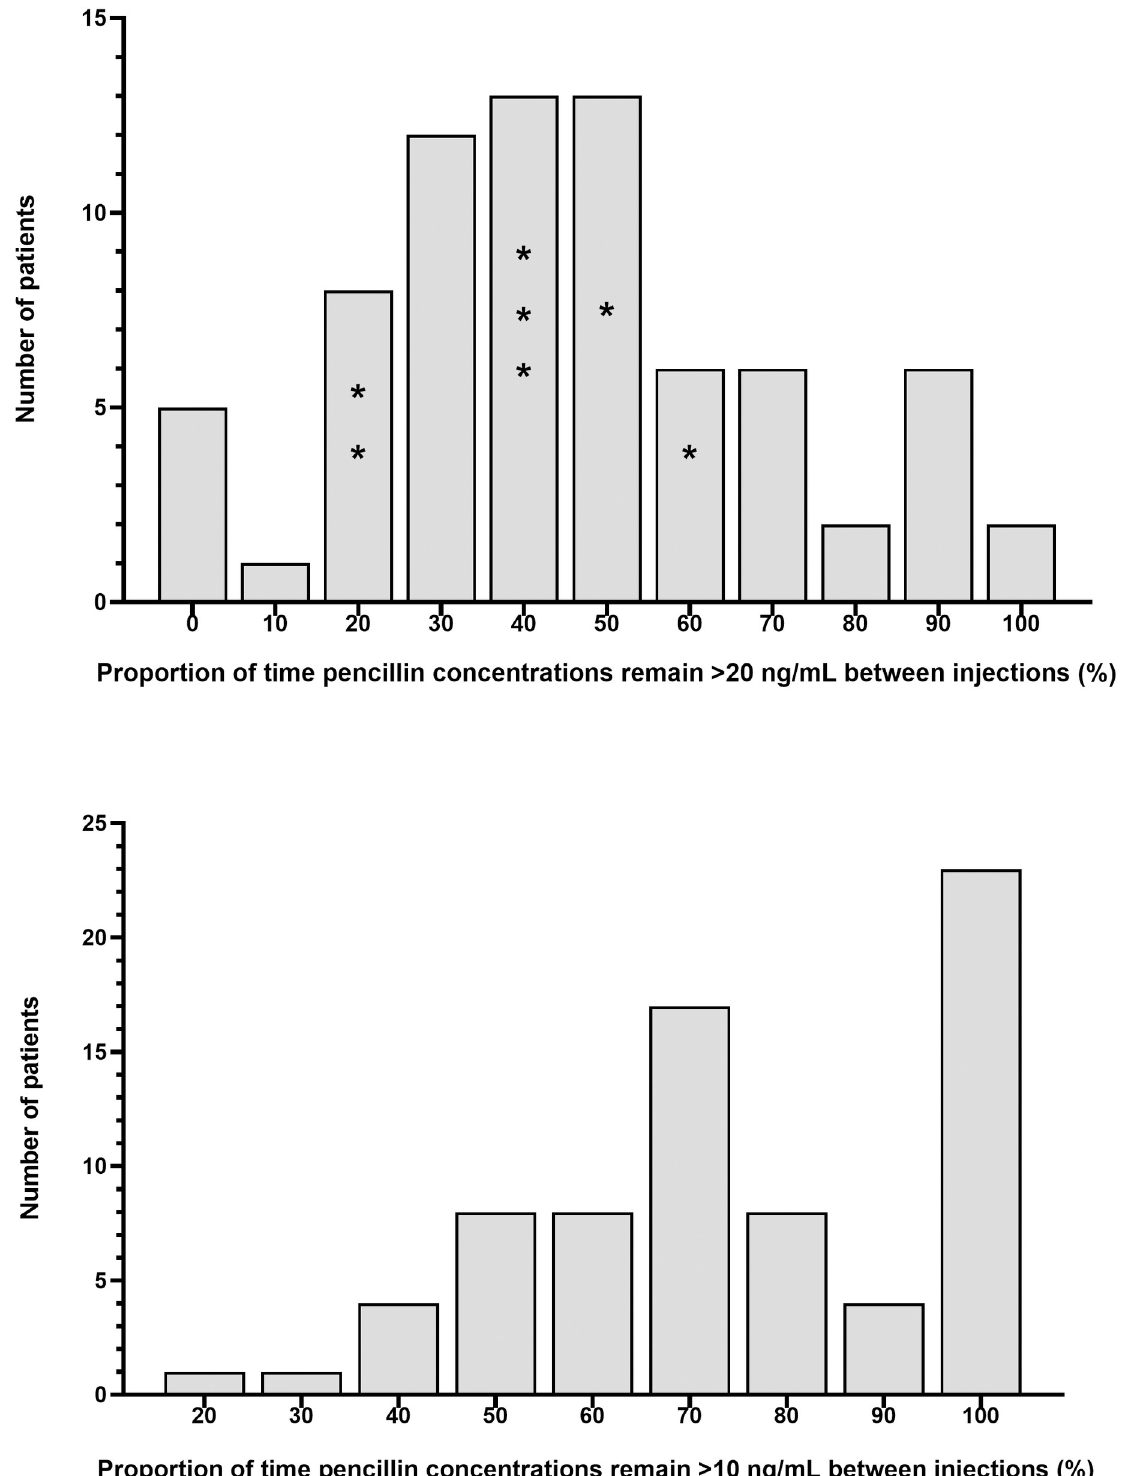
Fig 3. Histograms showing estimated time that penicillin concentrations remain greater than 20 ng/mL (Panel A) and 10 ng/mL (Panel B) following administration of intramuscular benzathine benzylpenicillin G to Ethiopian patients at risk of progressive rheumatic heart disease. Individuals with a self-reported episode of sore throat during the injection cycle are denoted ( � ).